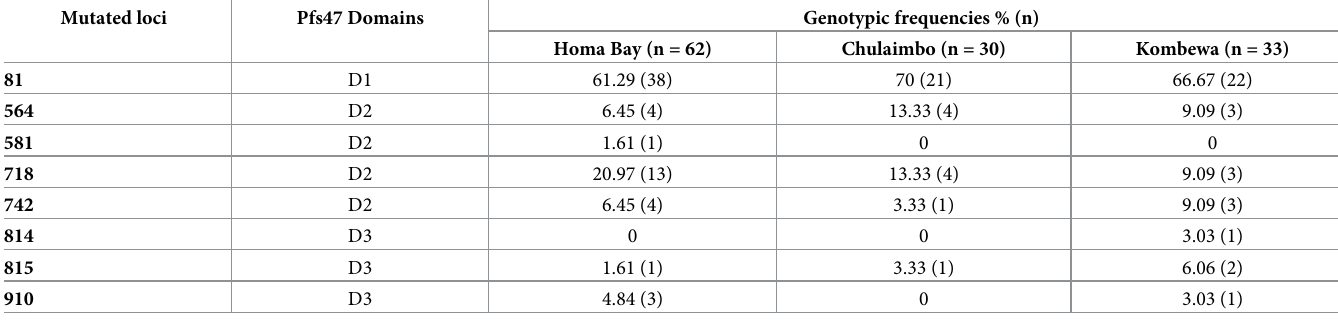
n is the total number